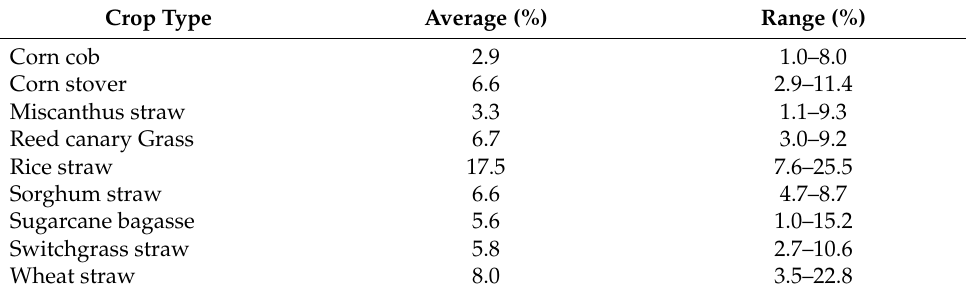
Table 2. The biogenic ash content of several herbaceous-biomass crops [45]. Crop Type Average (%) Range